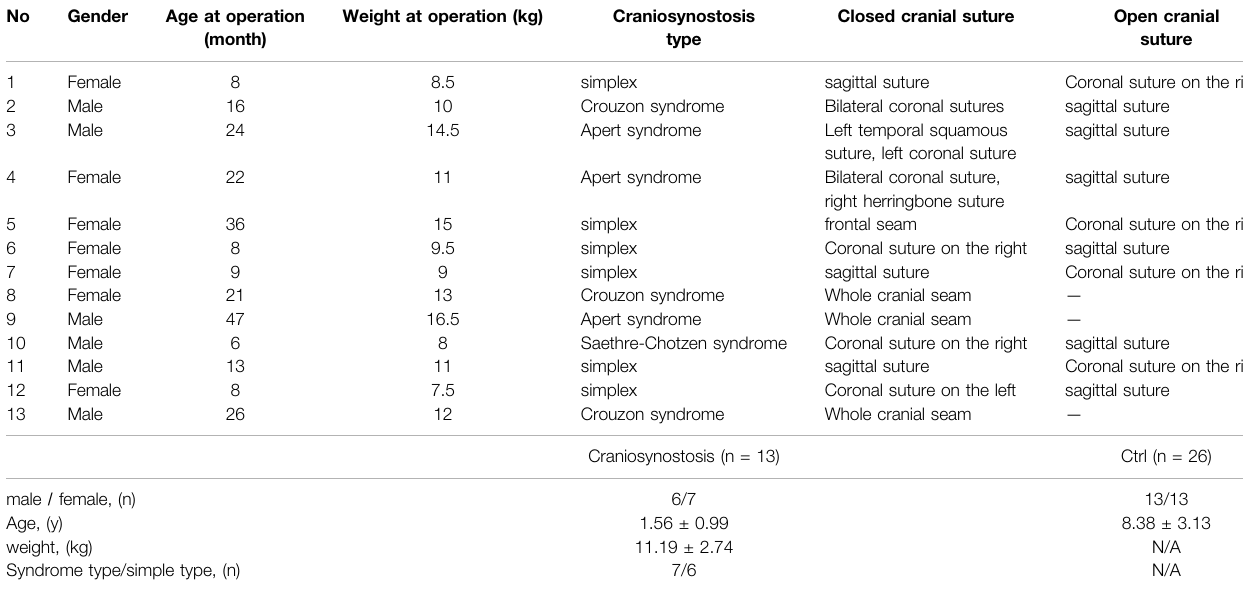
TABLE 1 | Baseline data of the